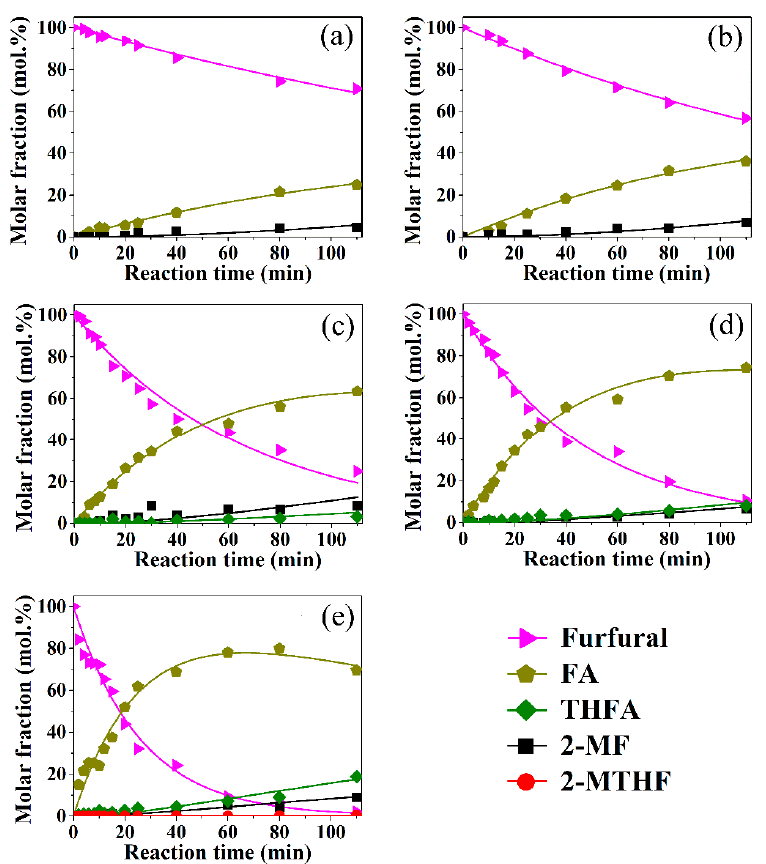
Figure 10. Dependence of reagent and products concentrations on the reaction time for the calcined and reduced Ni x MoC–SiO 2 (400/600) catalysts: ( a ) Ni 0.5 MoC–SiO 2 (400/600); ( b ) Ni 1 MoC–SiO 2 (400/600), ( c ) Ni 2 MoC–SiO 2 (400/600); ( d ) Ni 4 MoC–SiO 2 (400/600), ( e ) Ni 6 MoC–SiO 2 (400/600); symbols—experimental data, lines—calculated data; reaction conditions: T = 150 °C, P = 6.0 MPa, m cat